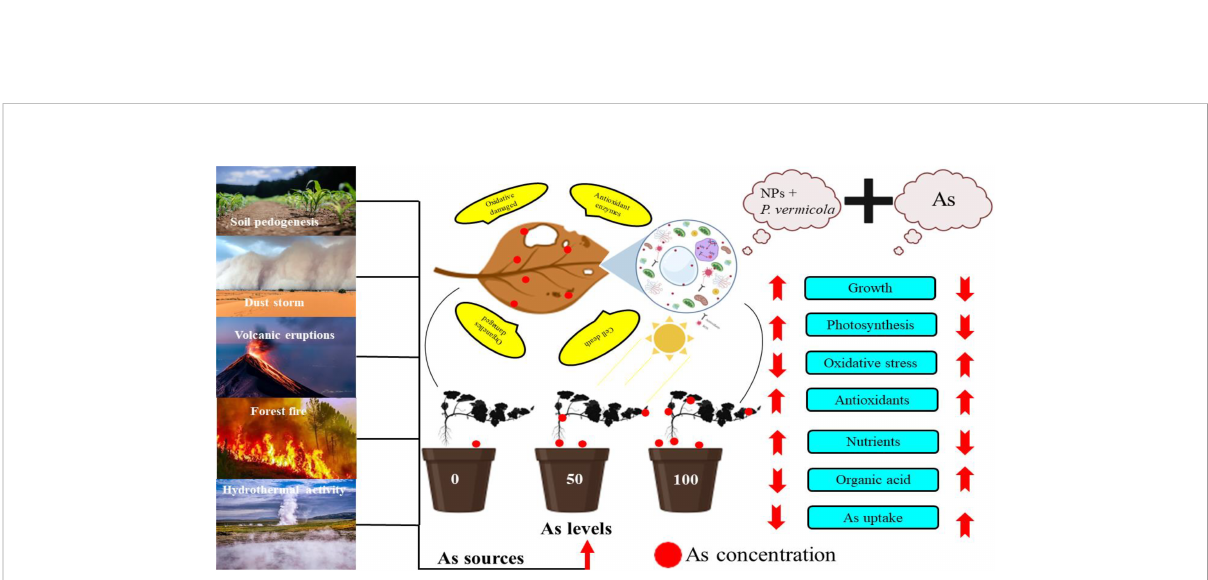
FIGURE 10 Schematic presentation of the fi ndings from this study under the application of Providencia vermicola ( P. vermicola ) and iron oxide nanoparticles (FeO-NPs) in arsenic (As)-stressed Ajwain [ Trachyspermum ammi ( T . ammi )] seedlings grown under different levels of As stress (i.e., 50 m M and 100 m M) in sandy loam soil. The fi gure shows As sources in the natural soil and its toxic effects on the plants. The fi gure also shows that As toxicity can be overcome by the application of P. vermicola and FeO-NPs, which decreased oxidative stress in membrane-bound organelles by decreasing As content in various parts of the plants. Overall, this scheme presents the complete description of this experiment and the important fi ndings that we have evaluated from the application of P. vermicola and FeO-NPs in As-stressed Ajwain ( T . ammi )